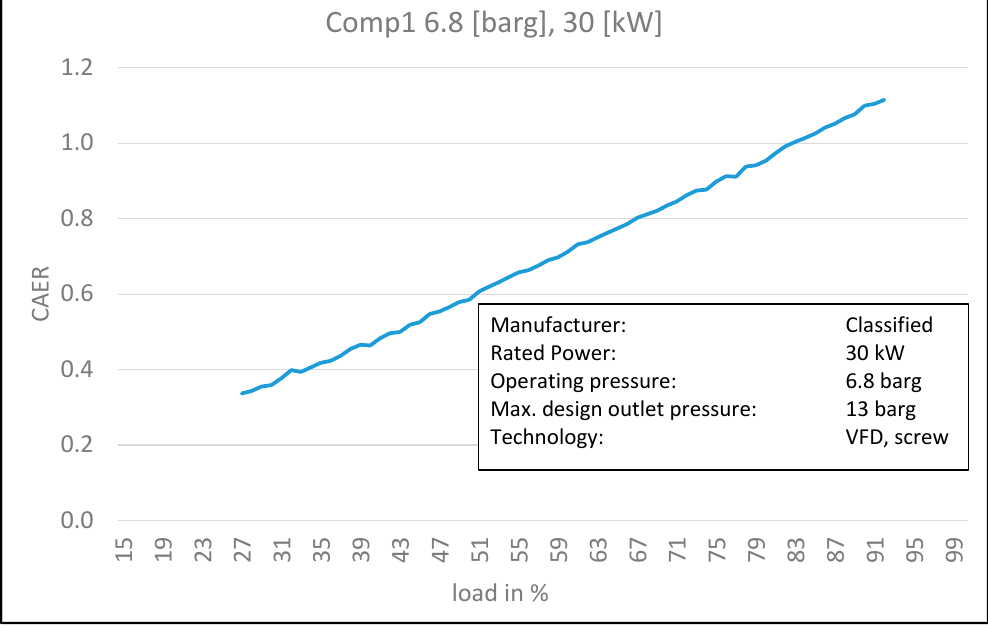
Figure 3. CAER over load stage (source: own representation).